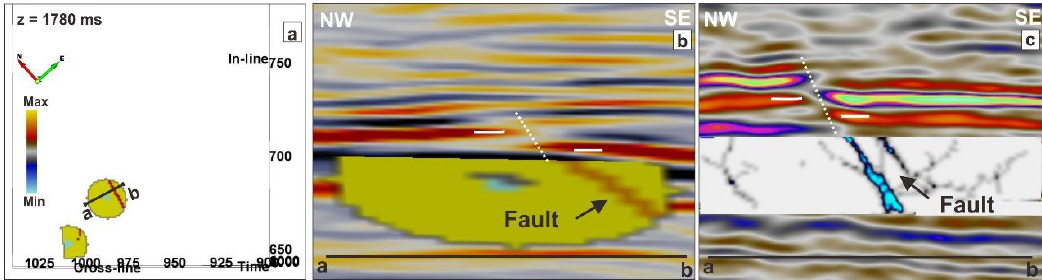
Figure 19. ( a ) Slice of the ANN–UVQ in 1780 ms. The associated seismic section ( a , b ) show the presence of a fault, ( b ) shows the overlay of the ANN–UVQ on seismic at inline 665, and ( c ) shows the overlay of the ACO attribute on a seismic section at inline 665.